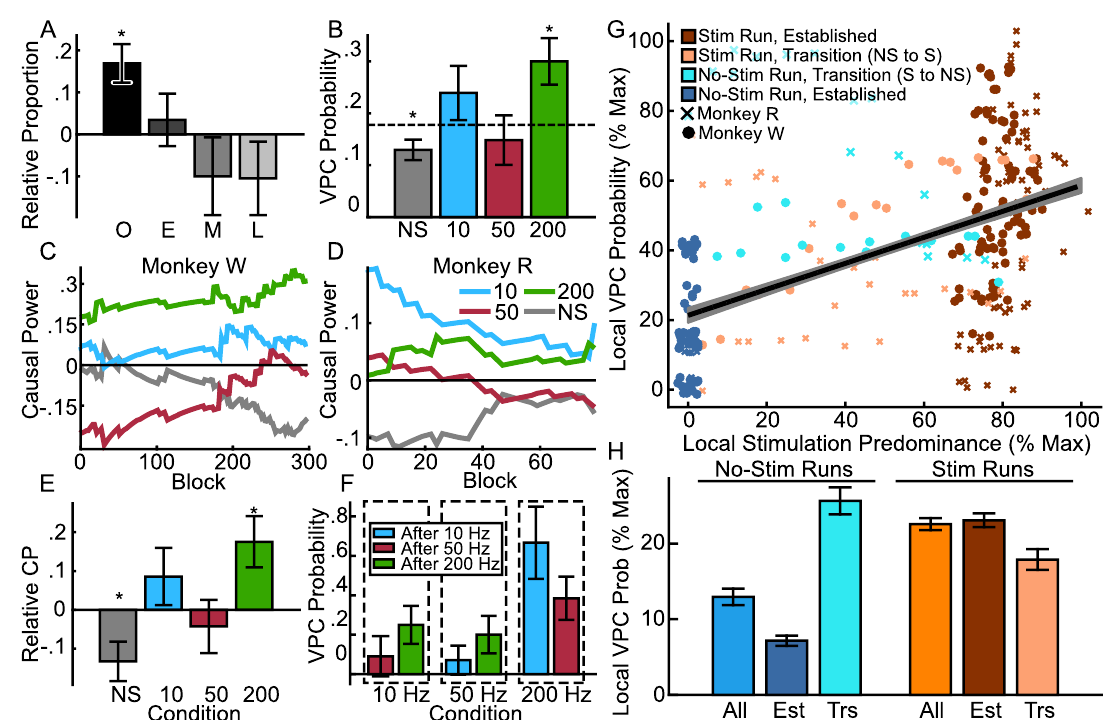
Fig 7. Thalamic DBS modulates VPC occurrence over acute and longer time frames. A , Relative proportion ( ± SD of the null distribution) of VPC events occurring around the onset (O, within 2 secs of stimulation start), early (E, 2-10s), middle (10-40s), or late (40-60s) phase of the 60s stimulations. B , Probability of VPC ( ± SD of the null distribution) across different experimental conditions: no stimulation (NS) and stimulations at 10, 50 and 200Hz. Dashed line indicates the average probability of VPC (the null hypothesis). C , D , Causal power by stimulation condition across experimental history (x axis starting when there are at least 10 blocks per condition to ensure robust causal power estimates) for ( C ) Monkey W and ( D ) Monkey R. E , Population CP ( ± SD of the null distribution) under the null hypothesis that CP is equal across conditions and no different from 0. F , Conditional probability ( ± SD of the null distribution) of VPC occurring with a particular stimulation frequency (10, 50 or 200Hz), given it was preceded by a different stimulation condition, under the null hypothesis that probability of VPC is consistent irrespective of preceding stimulations. G , Correlation (best fit line ± SE of the point estimate) of local VPC probability and stimulation predominance (% maximum, sliding window across 32 recording blocks). Individual data points shown for both animals (R and W) across stimulation and no-stimulation runs during transitional (first two days) and established (third day onwards) phases of an experimental series. H , Local VPC probability ( ± SE) for all data (All) in stimulation or no-stimulation runs, and further separated into established (Est) and transitional (Trs)